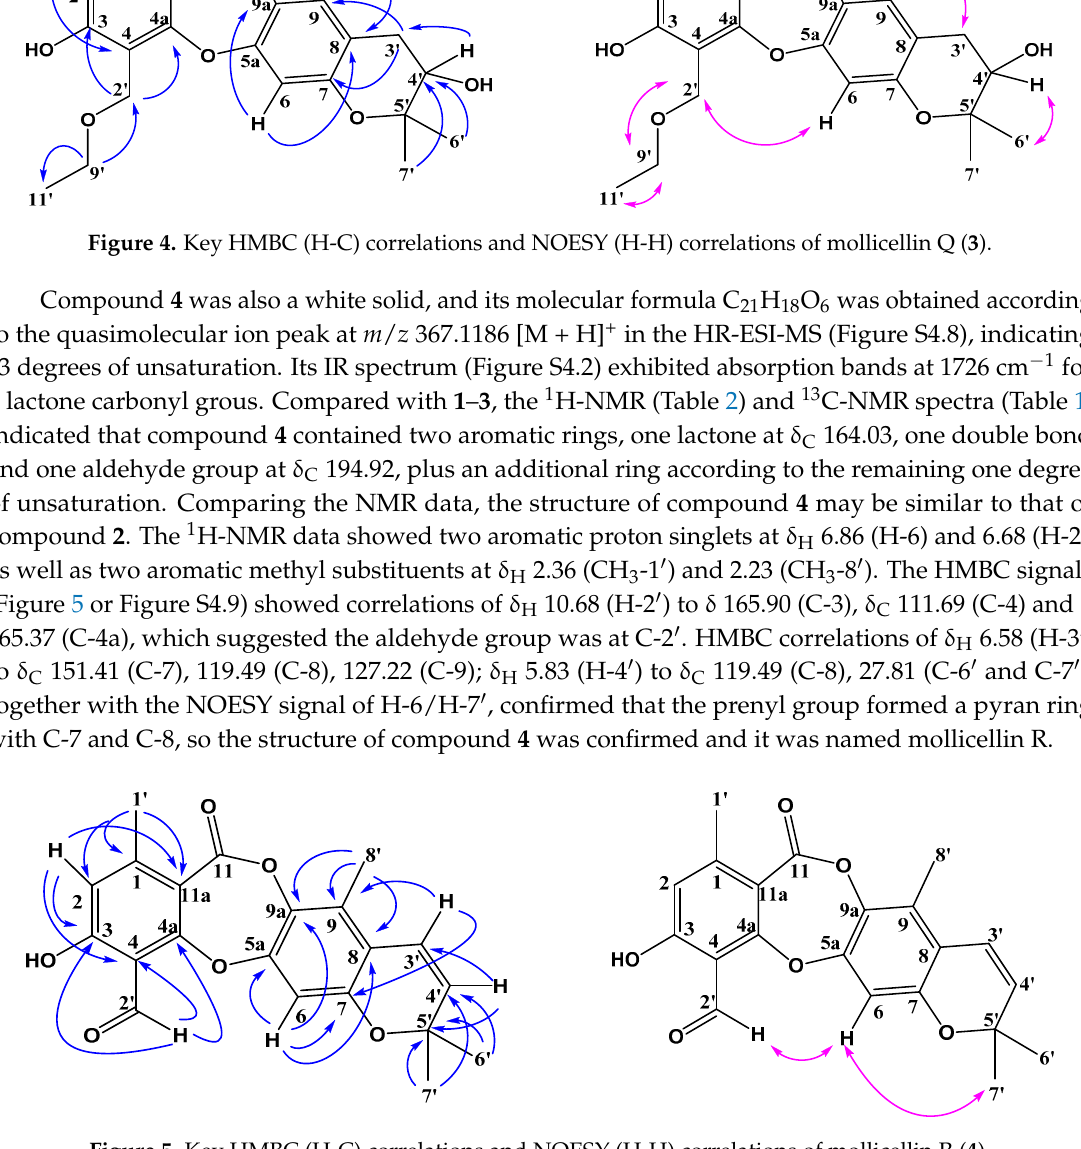
Figure 5. Key HMBC (H-C) correlations and NOESY (H-H) correlations of mollicellin R ( 4 ).